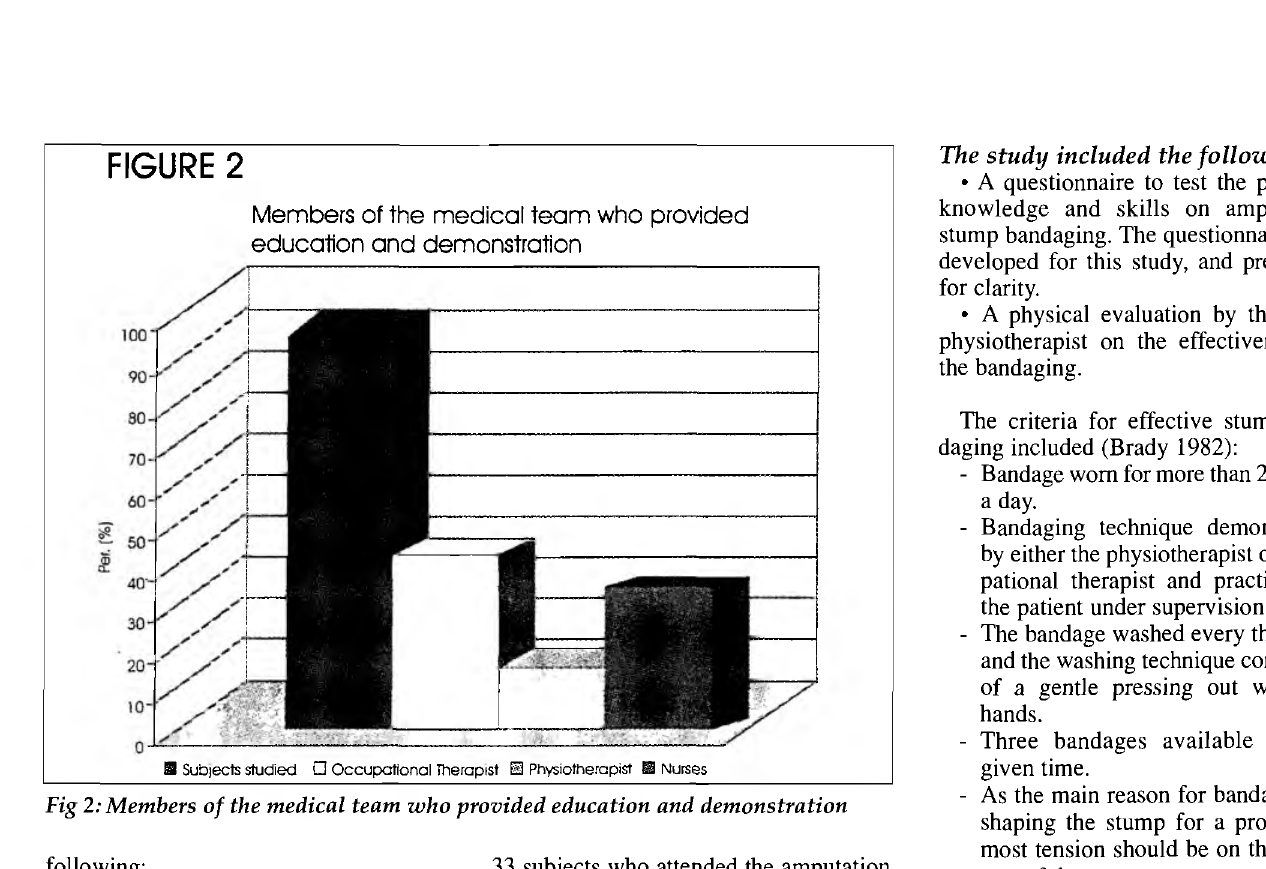
Members of the medical team who provided